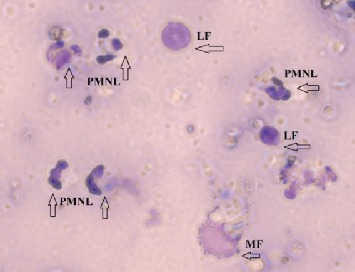
Microscopic examination of milk somatic cells smear. PMNL: polymorphonuclear leukocytes; LF: lymphocytes; MF: macrophages; original magnification 1000x.